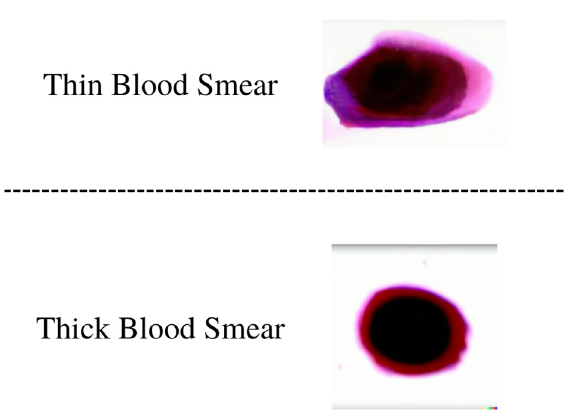
Figure 1. The glass slide with both thick and thin blood smears [6].